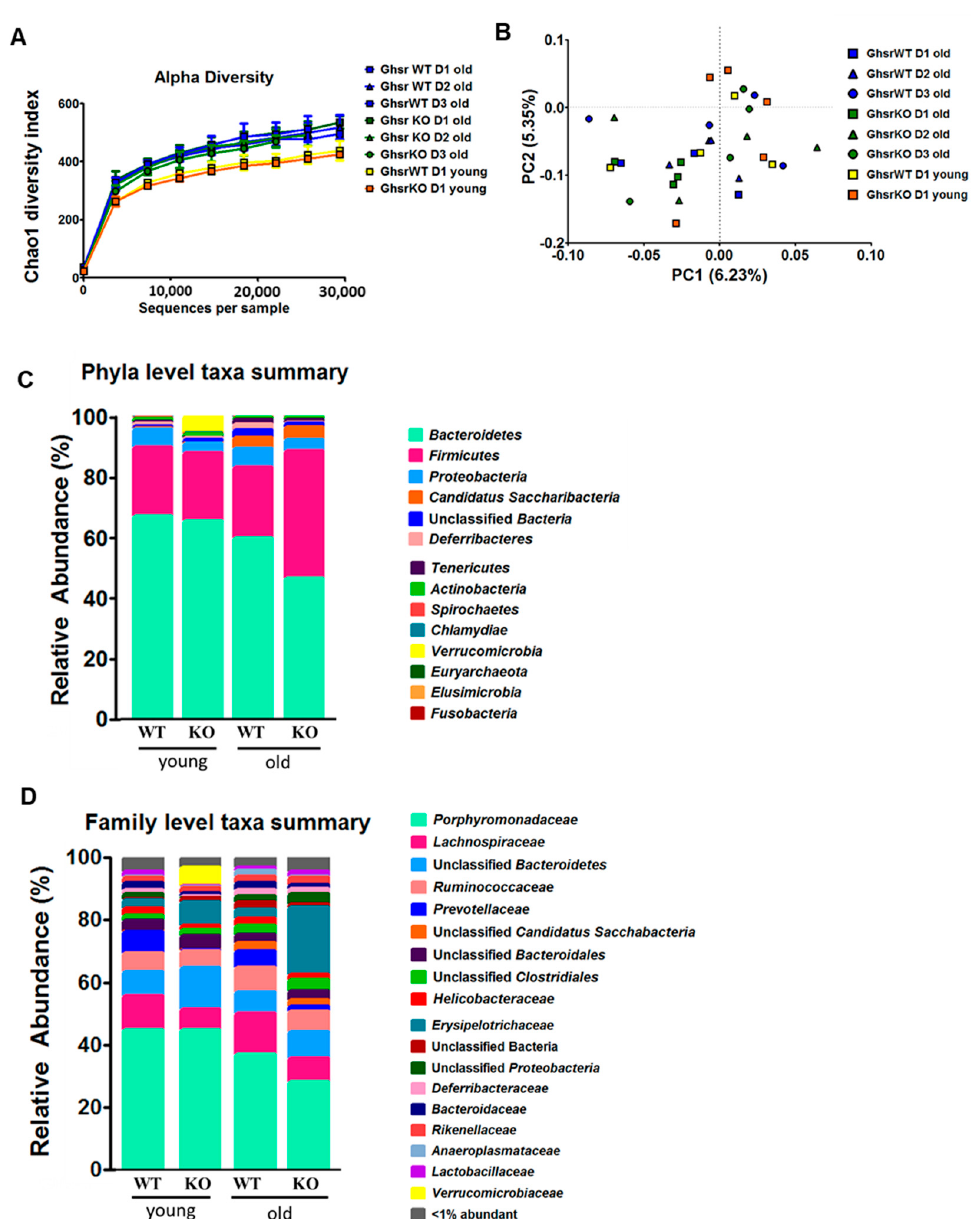
Figure 1. The microbiome profile is shifted in GHS-R KO of both young and aged mice. Reduced Bacteroidetes and increased Firmicutes are more pronounced in aged GHS-R KO rather than young mice. Feces from young (5-month) and old (14-month) male GHS-R KO mice were collected for 3 consecutive days (D1, D2, D3) and analyzed for microbial 16S rRNA. ( A ) α -diversity, ( B ) β -diversity, ( C ) relative abundance (%) at phyla level and ( D ) at family level. n = 4–5.